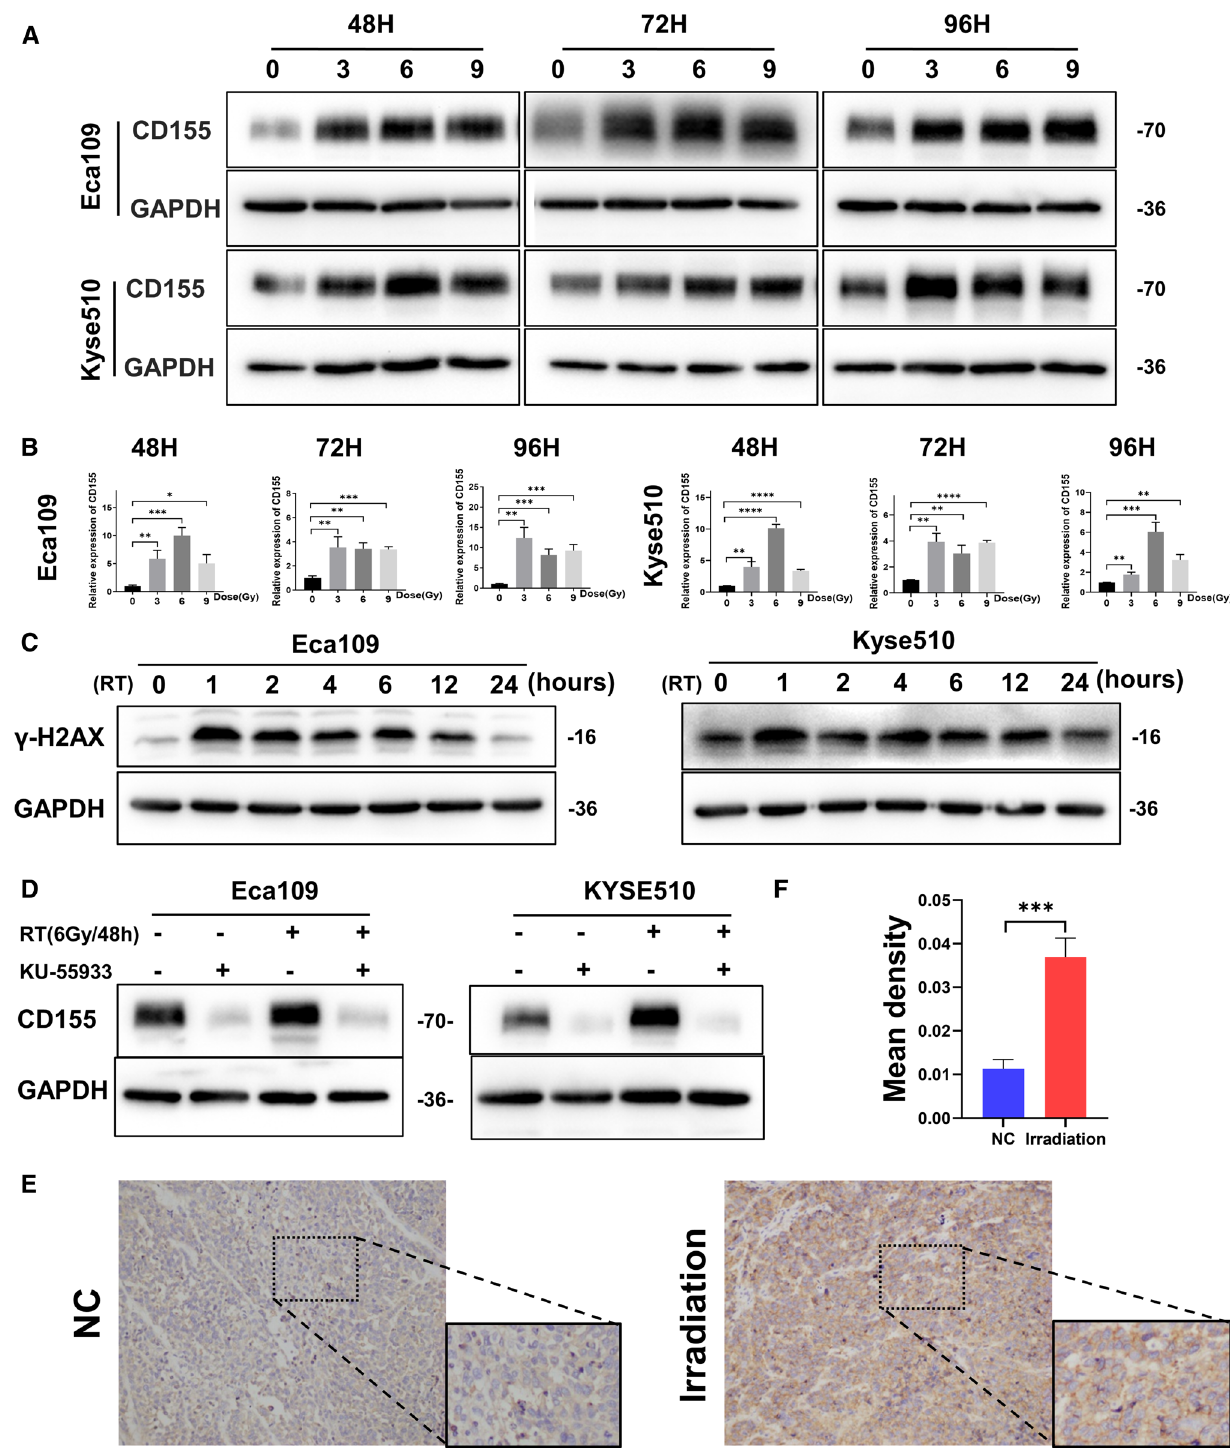
Fig. 2 CD155 expression levels in EC are upregulated after X-ray irradiation. A , B Analysis of CD155 expression levels in Eca109 and Kyse510 cultured cells after X-ray irradiation. A mRNA levels were analyzed using RT-PCR. B Protein levels were measured using western blot analysis. C Changes in the expression of γ-H2AX were detected by western blotting when the esophageal cancer cell lines were irradiated at 6 Gy within 24 h. D The expression of CD155 was detected via western blotting after the addition of the ATM inhibitor, KU55933. E Immunohis- tochemistry (IHC) analysis of CD155 protein expression in tumors of irradiated and non-irradiated nude mice. F Statistical analysis of IHC results presented in E . Data are expressed as the mean ± SD. *p < 0.05, ** p < 0.01 and *** p <